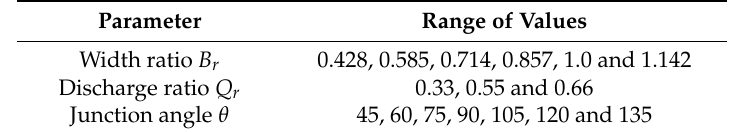
Table 4. Considered parameters and their range of variation in the numerical simulations.